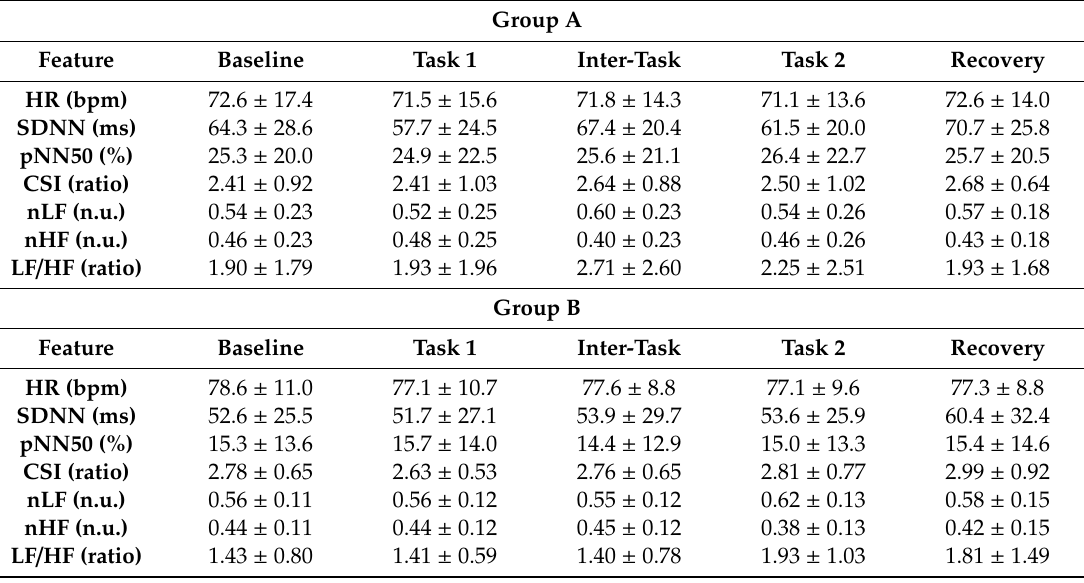
Table 1. ECG features, expressed as means ± SDs, for the two groups,